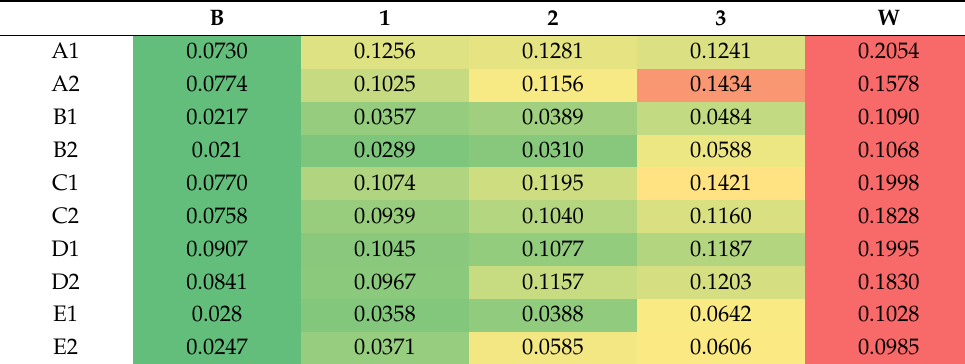
Table 3. Fitness function values in the five robot locations for individual trajectories—results from the simulation. Color gradient red–yellow–green is used for better visual representation of the value (green is the best, red is the worst).